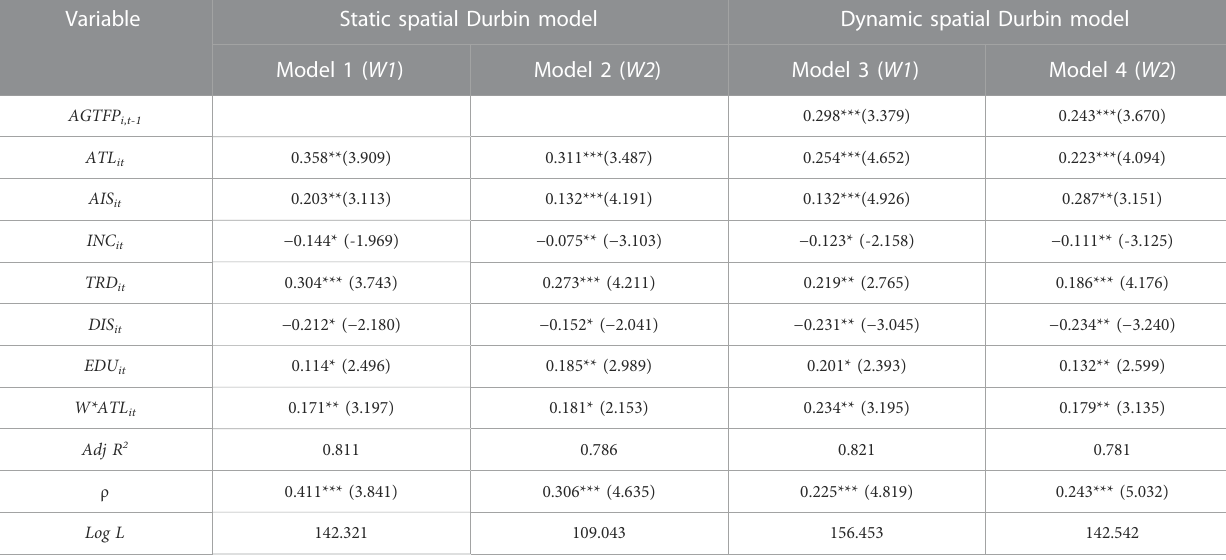
TABLE 8 Estimation results of spatial Durbin